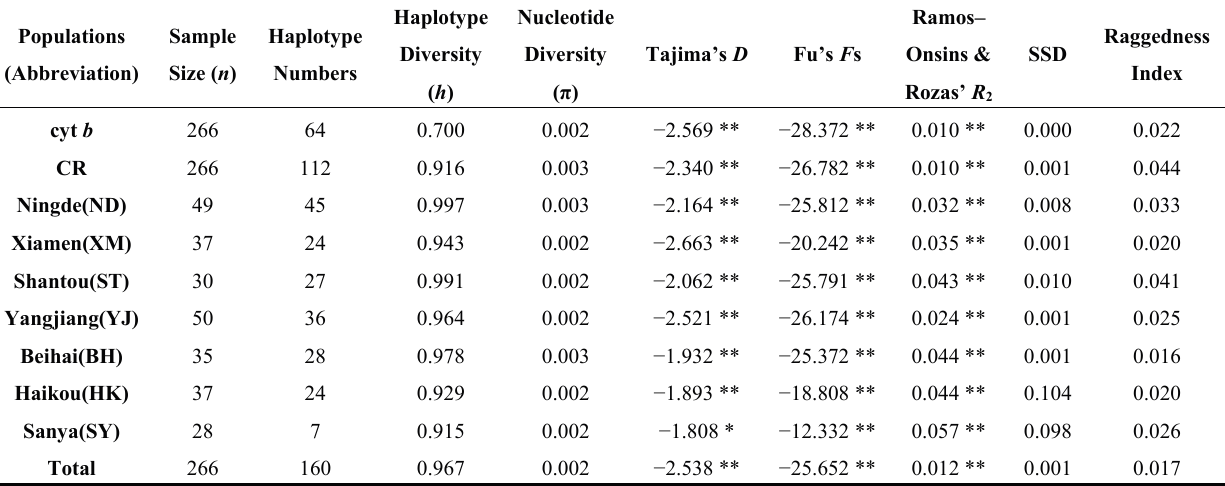
Table 1. Summary of sample size, haplotype numbers, haplotype diversity ( h ),